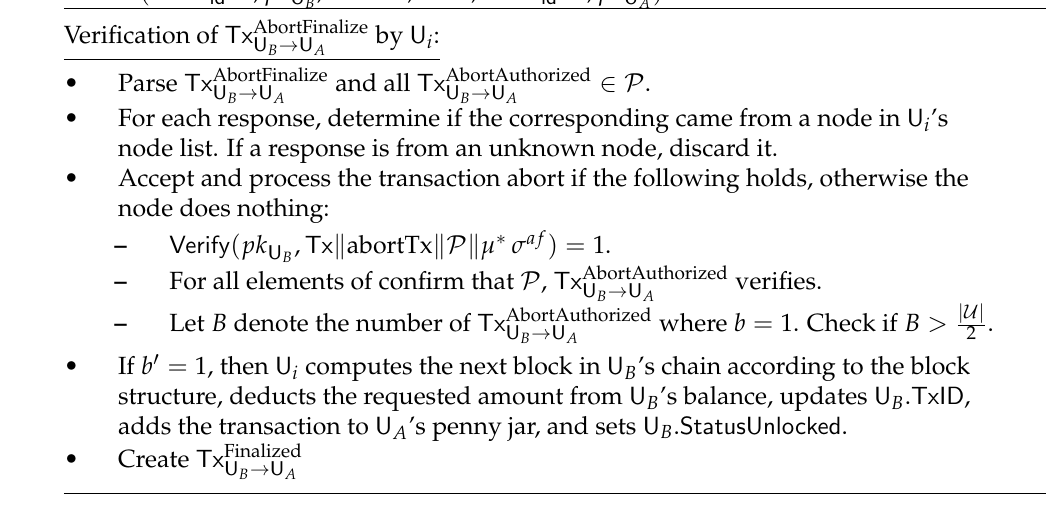
by nodes in Dandelion. B → U A